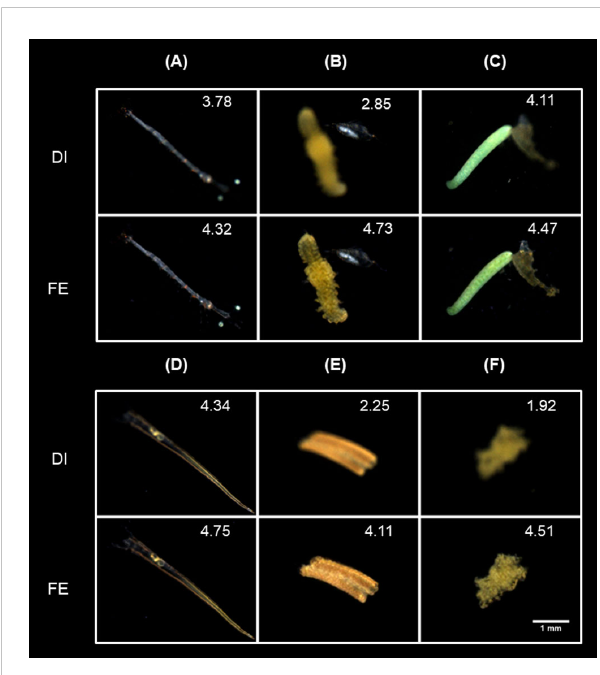
FIGURE 12 Focus-extension comparisons of IsPlanktonFE on some special in situ dark fi eld ROIs acquired by IPP. (A) A ROI contains an in-distribution plankter with different degrees of defocus in different body parts. (B) A ROI contains two different in-distribution plankters with different degrees of defocus. (C) and (D) contains an out-of-distribution (OOD) plankter, respectively. (E) and (F) contains an OOD suspended particle, respectively. The value at the top-right corner of each ROI indicates its focus score.